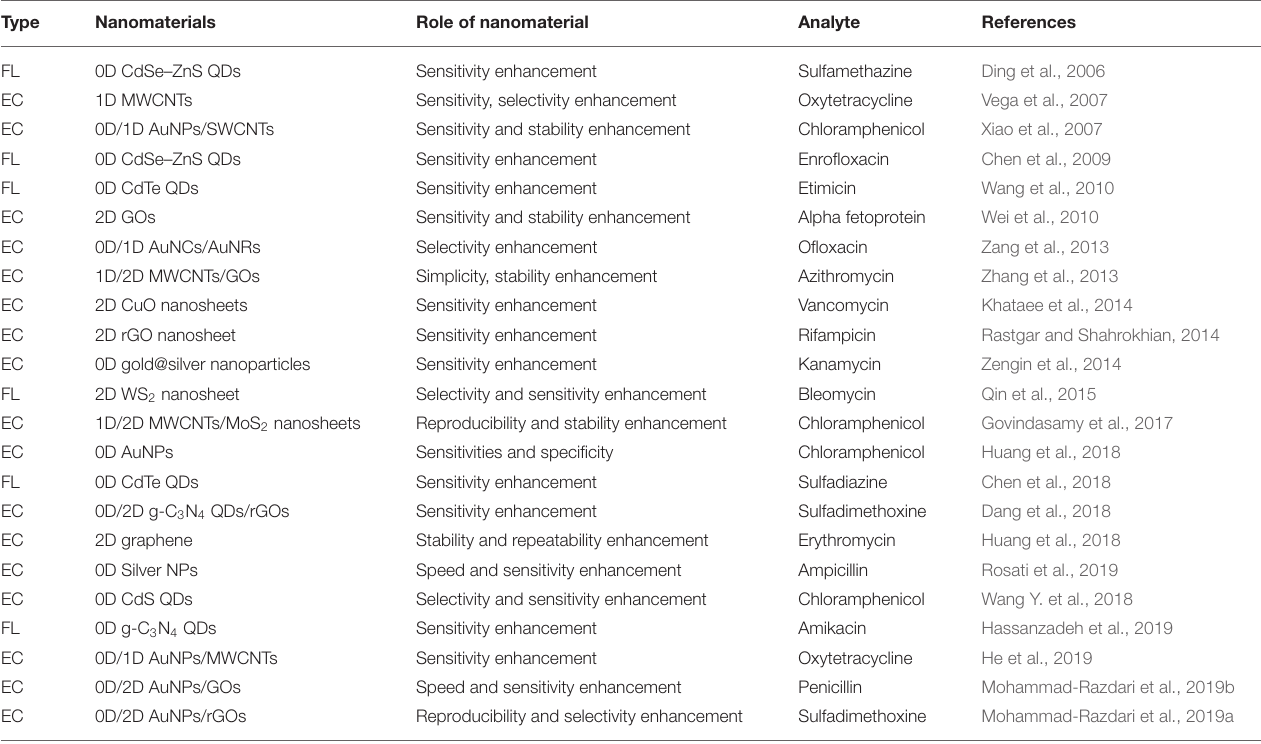
TABLE 1 | Characteristics of the different nanomaterials